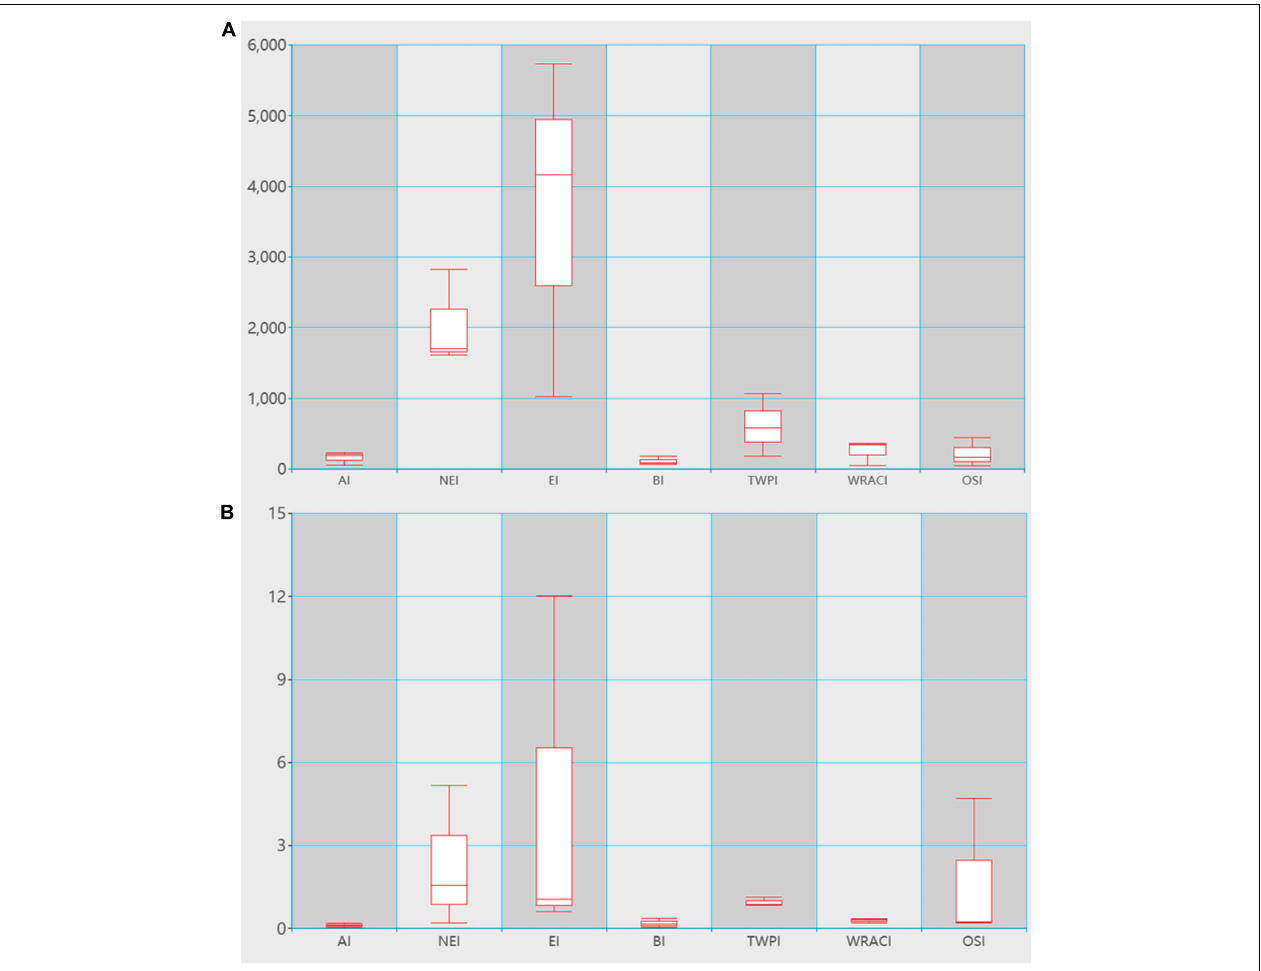
FIGURE 3 | (A) Comprehensive energy consumption of various industries in Shaanxi Province in 2007, 2012, and 2017; (B) energy consumption of 10,000 yuan in Shaanxi industries in 2007, 2012, and